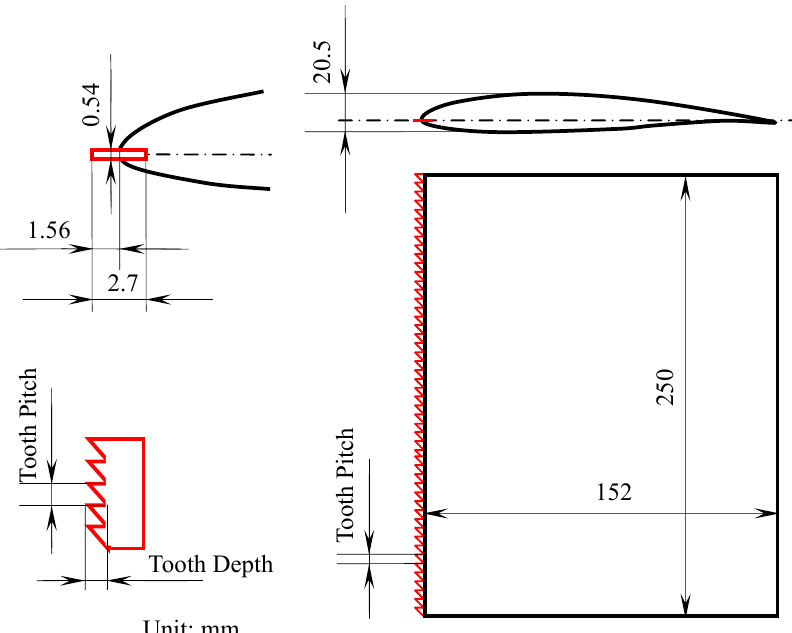
Fig.2 Airfoil Section of NASA63-414, Ref. (4) and Dimension of Airfoil Tested. Jigsaw Blades were Attached to the Leading Edge with a